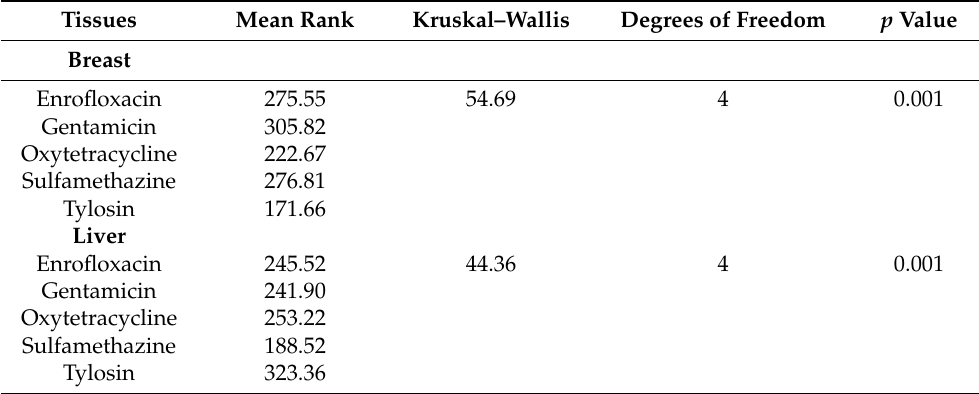
(Table 3). Overall, five of the antibiotic residues detected from the chicken breast and liver were statistically significant, as indicated by the Kruskal–Wallis test ( H (4) = 54.69, p < 0.05) and ( H (4) = 44.36, p < 0.05), respectively (Table 3). Table 3. Comparison of the mean rank between the five antibiotic residue concentrations ( µ g/kg) detected in each tissue of liver and breast of broiler chicken using Kruskal–Wallis test.